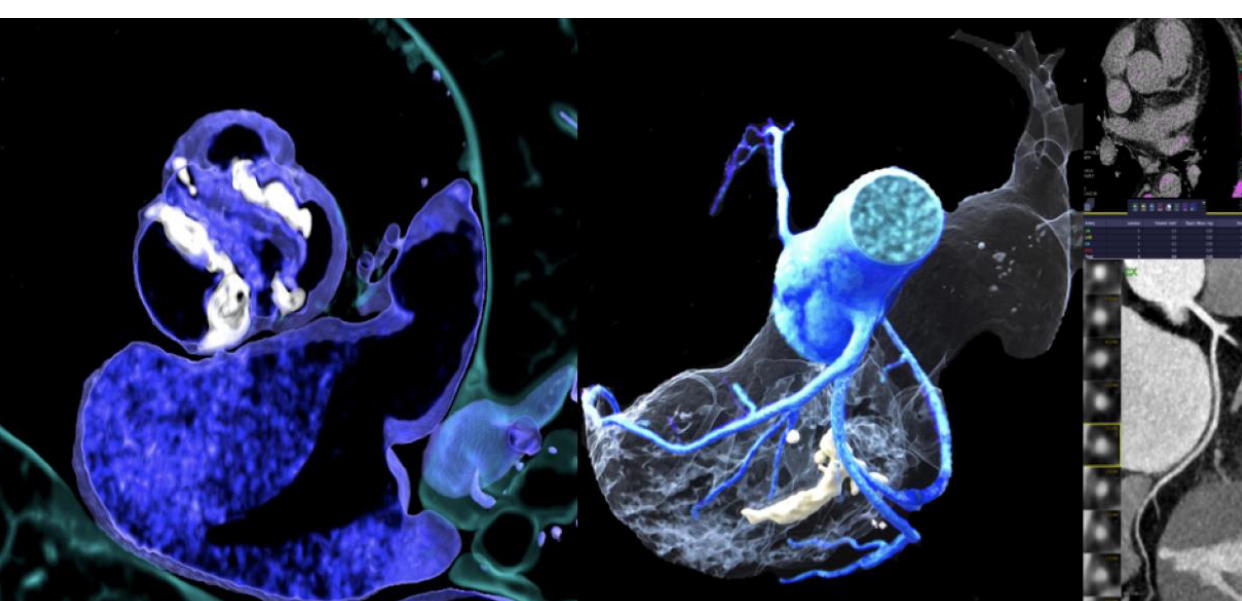
Figure 1. ( a ). Computed tomography (CT) findings ( a ) Coronary artery calcium score (CACS) in patients with bicuspid aortic valve (BAV) stenosis was significantly lower ( p < 0.001) as compared to tricuspid aortic stenosis (TAV). ( b ). Coronary artery stenosis severity (CADRADS) in patients with bicuspid aortic valve (BAV) stenosis was lower ( p < 0.001) as com- pared to tricuspid aortic stenosis (TAV). Dot = extreme values.